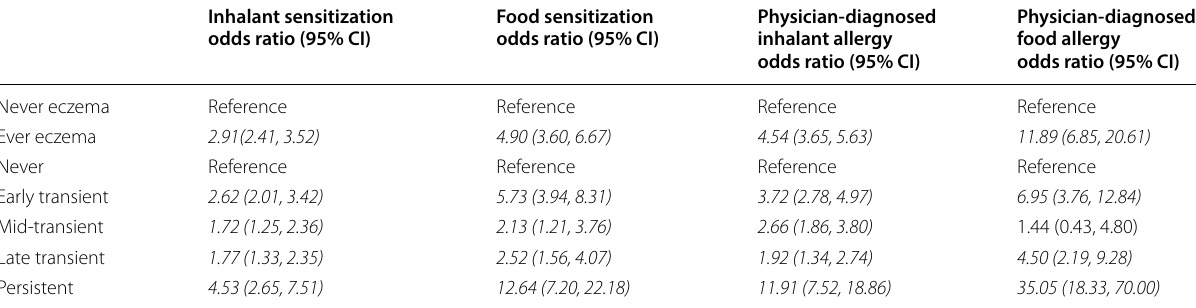
Values are odds ratios (95% confidence intervals) from logistic regression models for never/ever eczema and average odds ratios (95% confidence intervals) from logistic regression models after multiple sampling based on 150 imputed datasets for eczema phenotypes. Full models were adjusted for parental history of allergy, asthma or eczema, maternal education, parity, child’s sex, ethnicity and breastfeeding. Italic values indicate statistical significance at the α